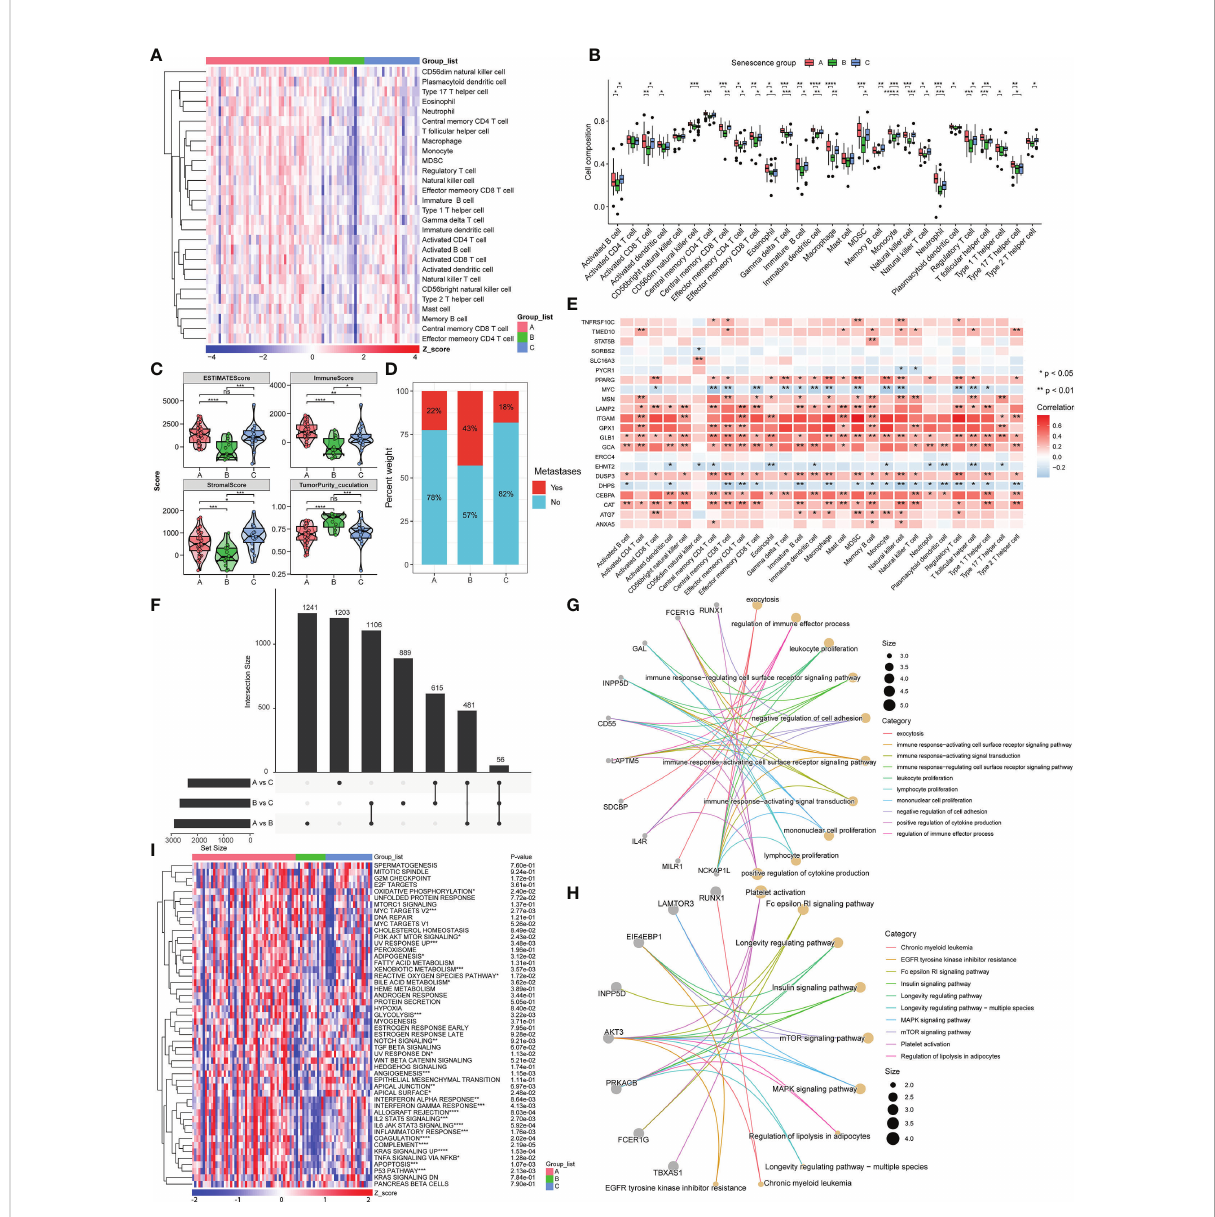
FIGURE 2 Immune status and functional analysis of DEGs in the three subgroups. (A, B) Heatmap and box plot of the statistical analysis of the ssGSEA results. (C) Estimate evaluation, immune status, stromal status, and tumor purity calculated for the three clusters using the ESTIMATE algorithm. (D) Proportion of patients with metastasis in the three subgroups. (E) Correlation between 22 prognosis-related ASIGs and 28 immune cells. (F) DEGs in the three subgroups (|log2FC|>0.25, p-value<0.01). (G, H) Network diagram constructed from the GO and KEGG analysis of DEGs. (I) Heatmap of GSVA results of the hallmark pathway (ns, not signi fi cant, *p< 0.05, ** p< 0.01, *** p< 0.001, ****p<